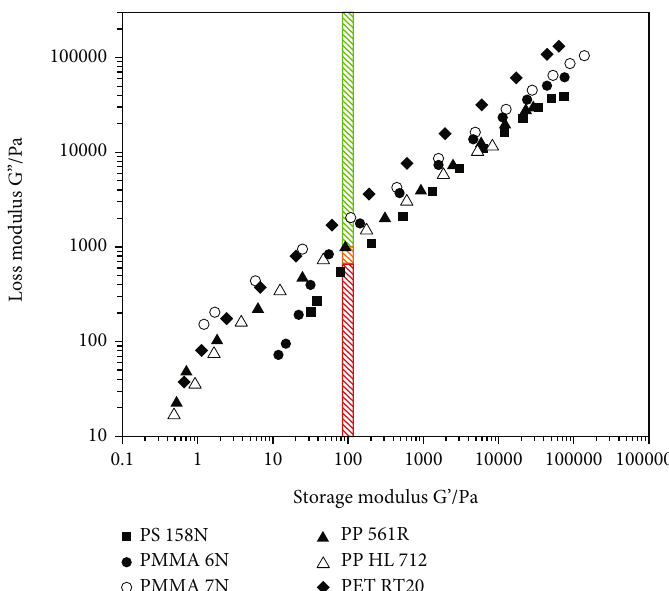
Figure 9: Estimation of the spinnability of the used polymers using the loss and storage module-dependence found by Beyreuther and Vogel [32]. For PS 158N, the value indicates poor spinnability.